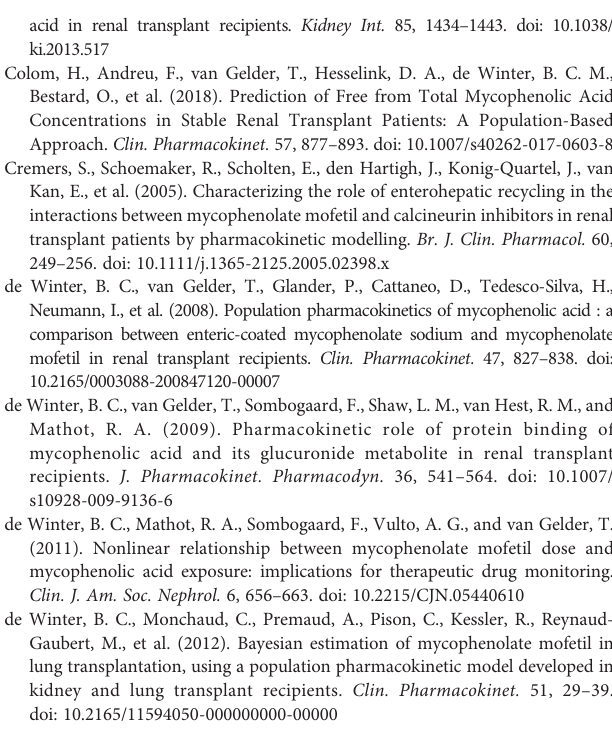
SUPPLEMENTARY TABLE 1 | Key covariate model development steps SUPPLEMENTARY TABLE 2 | Sensitivity analysis of observations over ±4